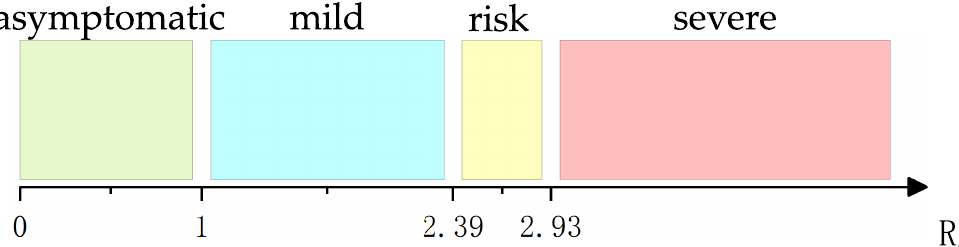
Figure 6. Classification of patients based on basic reproduction number. If R 0 ≤ 1, the patient is asymptomatic. If 1 ≤ R 0 < 2.39 ,the patient is mild. If 2.39 ≤ R 0 < 2.93 , the patient is at risk of becoming severe. If R 0 ≥ 2.93, the patient is severe. Patients at risk of mild to severe disease should be focused